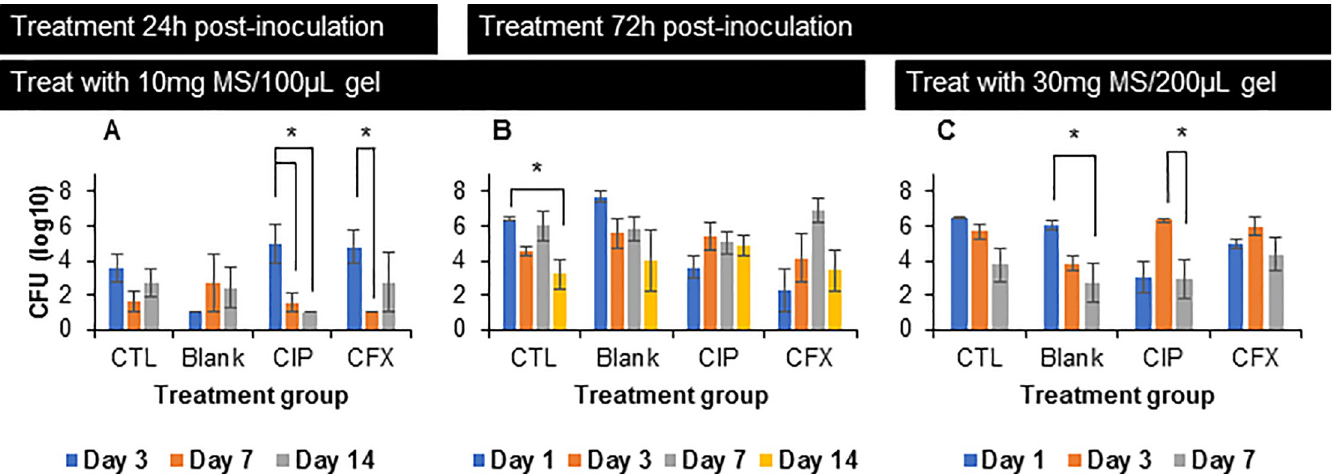
Fig 8. In vivo efficacy of gel/microsphere (MS) drug delivery system. Colony forming units (CFU) of Haemophilus influenzae bacteria in chinchilla middle ear after treatment with gel/MS containing: ciprofloxacin (CIP), ceftriaxone (CFX), blank, or no treatment control (CTL). Treatment was applied in concentrations of 10mg MS/ 100 μ L gel (A,B) or 30mg MS/200 μ L gel (C) at 24h (A) or 72h (B,C) after bacterial inoculation. Bacterial counts were determined upon sacrifice at time points including days 1, 3, 7, 14 post-treatment. Error bars represent the average ± standard error for n = 4 samples except groups in cohort A: CTL contains n = 9 samples and Blank, CIP, and CFX contain n = 3 samples